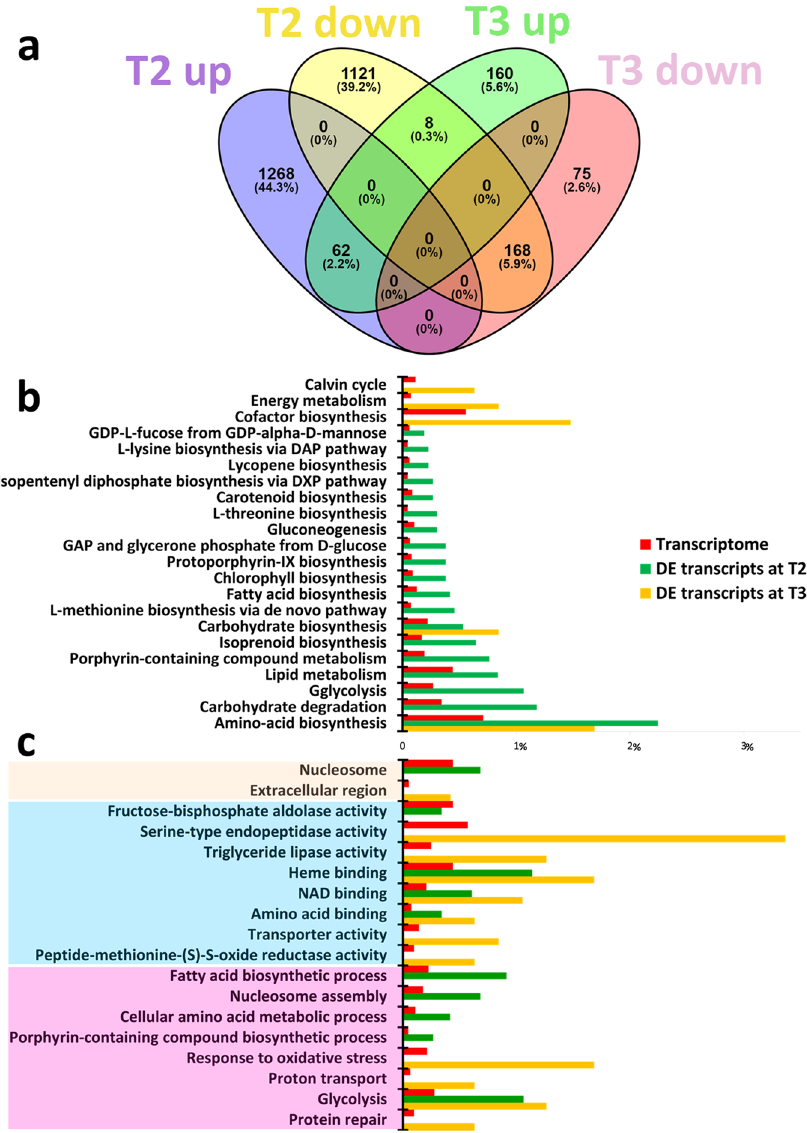
Figure 1. Differential expression analyses in Chaetoceros decipiens . ( a ) Venn diagram of DE transcripts at time points T2 and T3. Number of transcripts and percentage are shown. Venn diagrams have been produced using Venny 2.0 online software 71 . ( b , c ) Representation of ( b ) KO pathway level 1 and ( c ) GO terms significantly enriched for DE transcripts. The charts show the proportion of transcripts associated to the significant classes for DE transcripts at time points T2 (green) and T3 (yellow) and their respective proportion in the assembled reference transcriptome (red). Colour shades indicate cellular components (ochre); biological processes (blue); molecular function (pink). On the x-axis, the percentage of transcripts associated to a given KO ( b ) or to a specific GO term ( c ) calculated over the total number of transcripts in the given dataset is